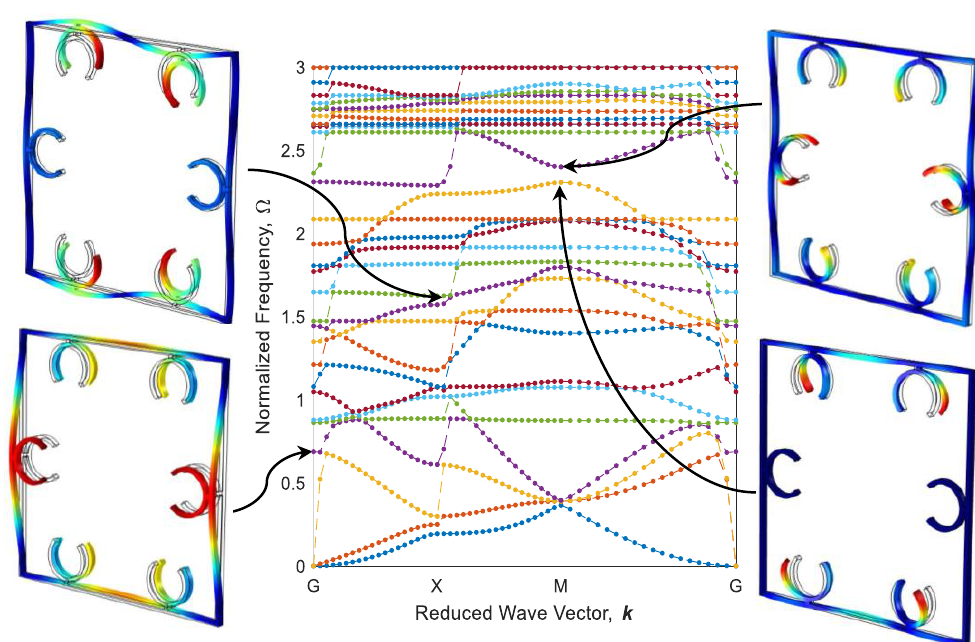
Figure 20. The counterpart of Figure 17 for 70 mm/s.